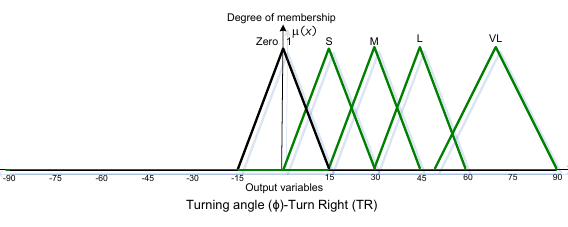
Fig. 11. The membership functions for output variables “turn